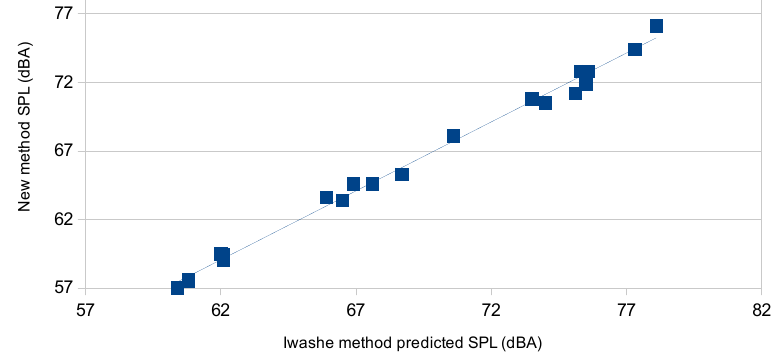
Figure 10. Correlation analysis for attenuation between A-weighted response, as measured utilizing the Iwase [12] three-microphone method, versus the new proposed SIM method.